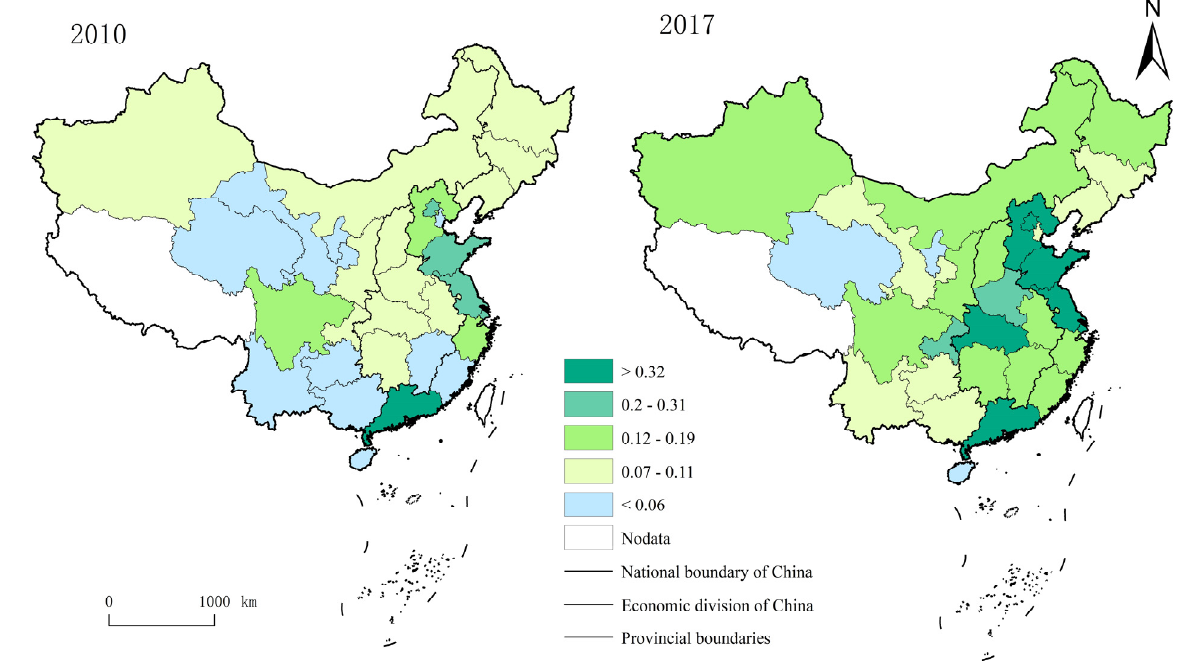
Figure 2. Spatial distribution of green finance in China from 2010 to